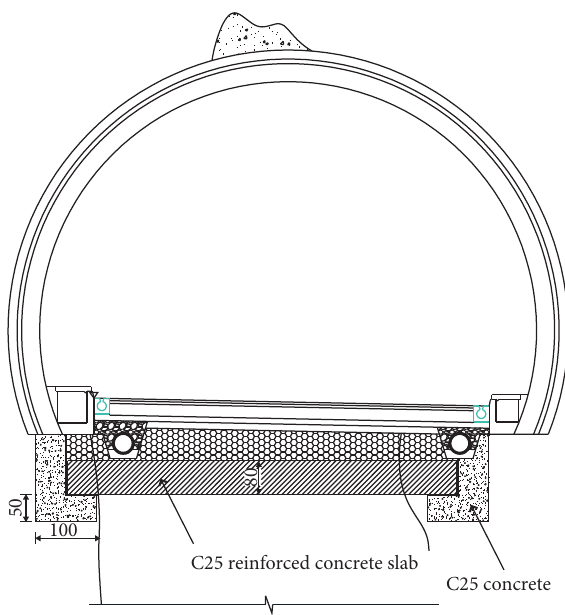
Figure 10: Large karst cavern below the tunnel base.